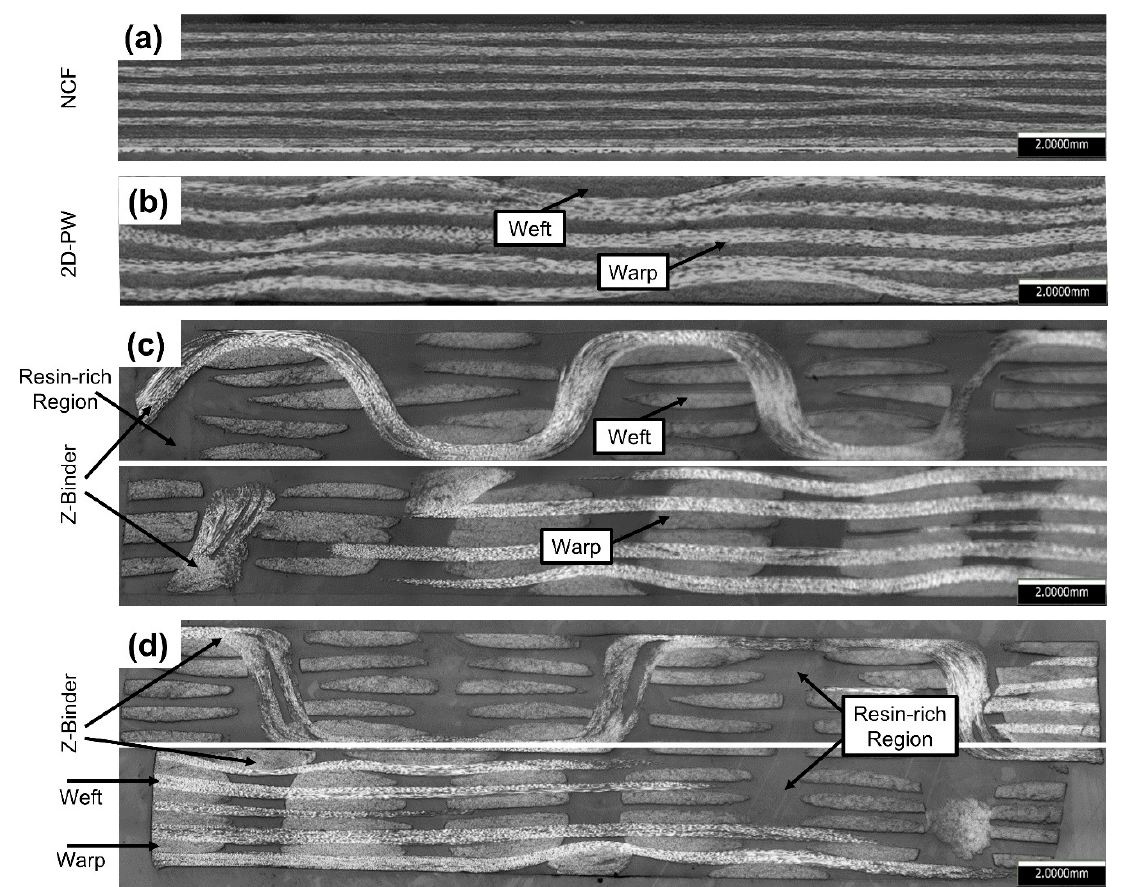
Figure 3. Optical micrographs of composites cross-sections: ( a ) NCF, ( b ) 2D-PW, ( c ) ORT-PW and ( d ) ORT-TW. For ORT-PW and ORT-TW architectures, two micrographs were captured: along the warp (top image) and along the weft (bottom image).